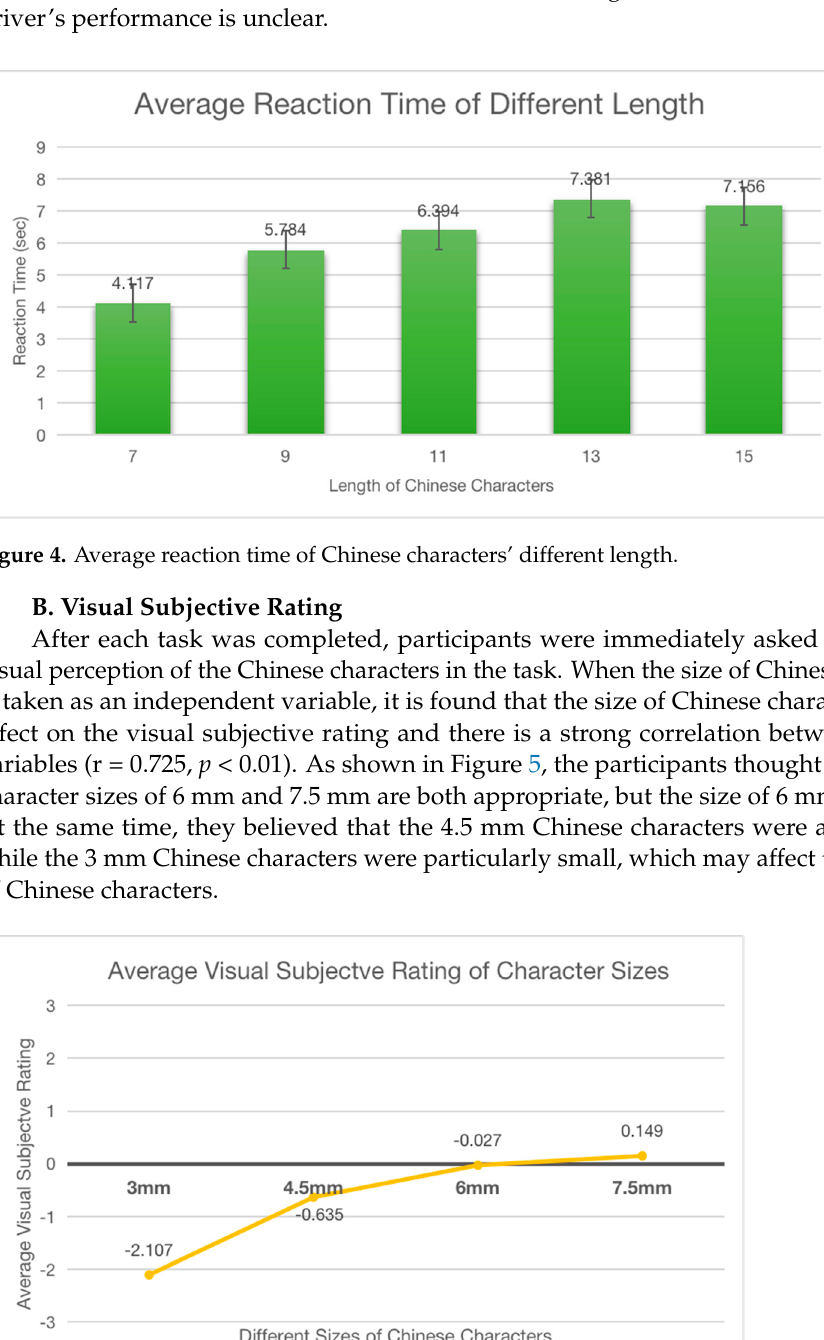
Figure 3. Average reaction time of Chinese characters’ different sizes.